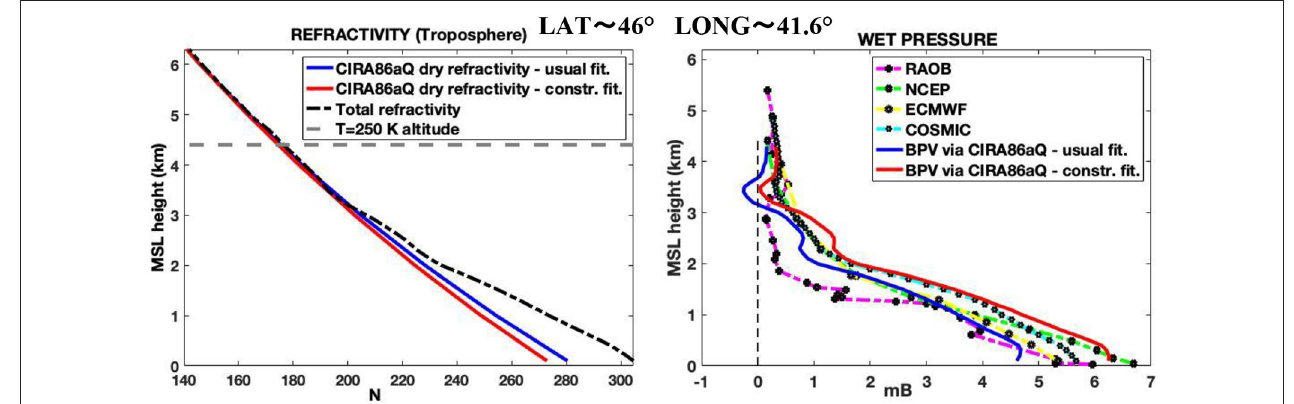
FIGURE 6 | Even if less frequently with respect to the Hopfield model, wet pressure negative values may occur with the CIRA85aQ as well. In this case too, negative values disappear when the second constrained fitting is